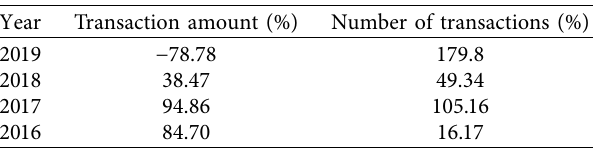
Table 4: The growth of the transaction amount and number of